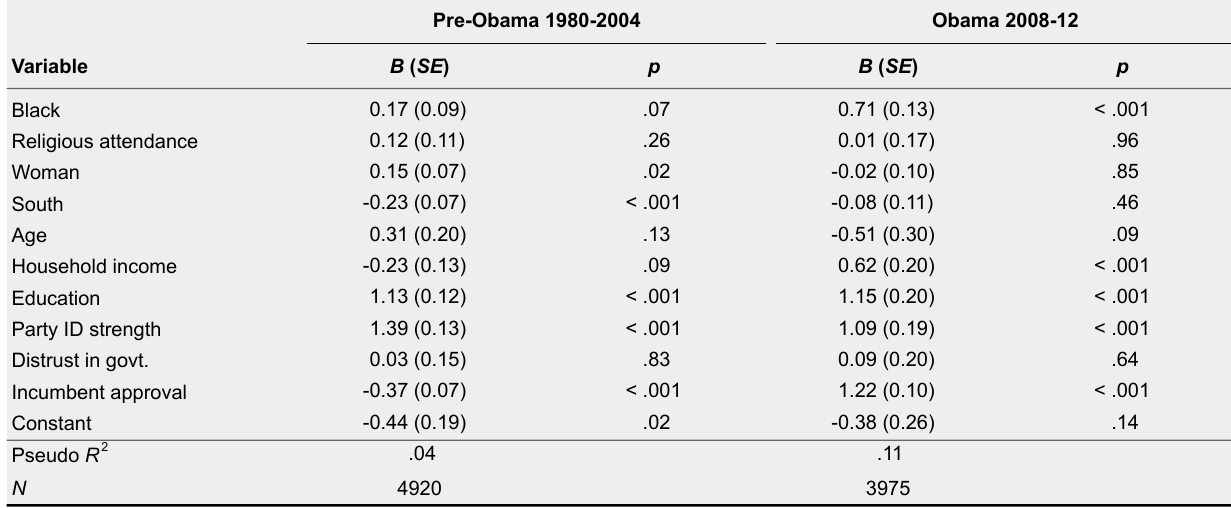
Logit Models Regressing Race on Democrats’ Reported Hope Toward Favored Partisans, Across Pre-Obama and Obama Years